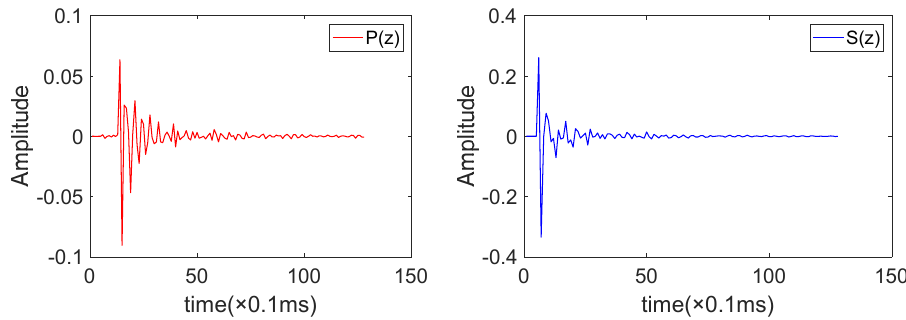
Figure 5. Shock response of the primary channel P( z ) and secondary channel S( z ).